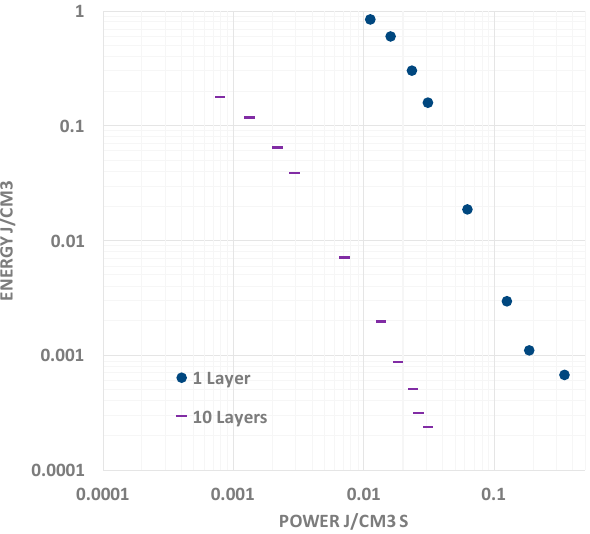
Figure 7. Ragone Plot Presentation. The data obtained for two of the F-SDM based capacitors studied are shown. As with other types of capacitors, as the energy density decreases, the power output increases. The basis for this relationship is that as the discharge time decreases, the energy density decreases, but more slowly. Thus, the energy delivered per unit time (power) increases with decreasing discharge time.